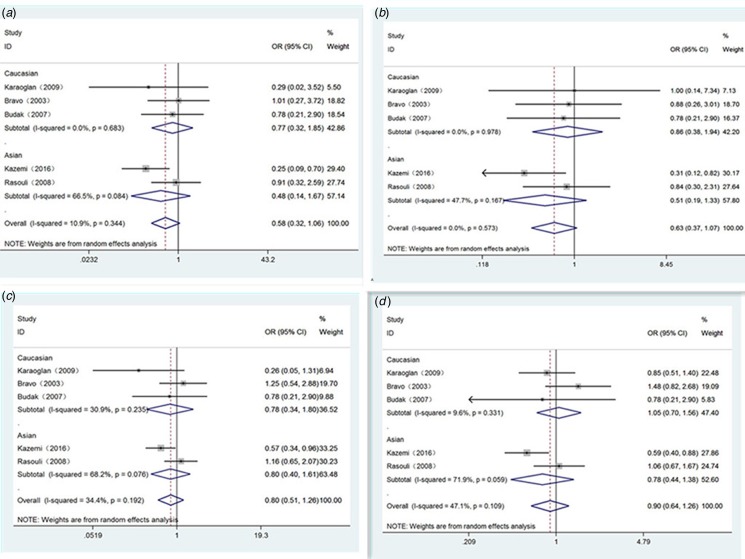
Forest plot of IL-10-592 loci polymorphism on Brucellosis risk in different genetic models. A: recessive model (AA vs. CC/AC); B: dominant model (AA/AC vs. CC); C: homozygote model (AA vs. CC) and D: allele model (A vs. C).